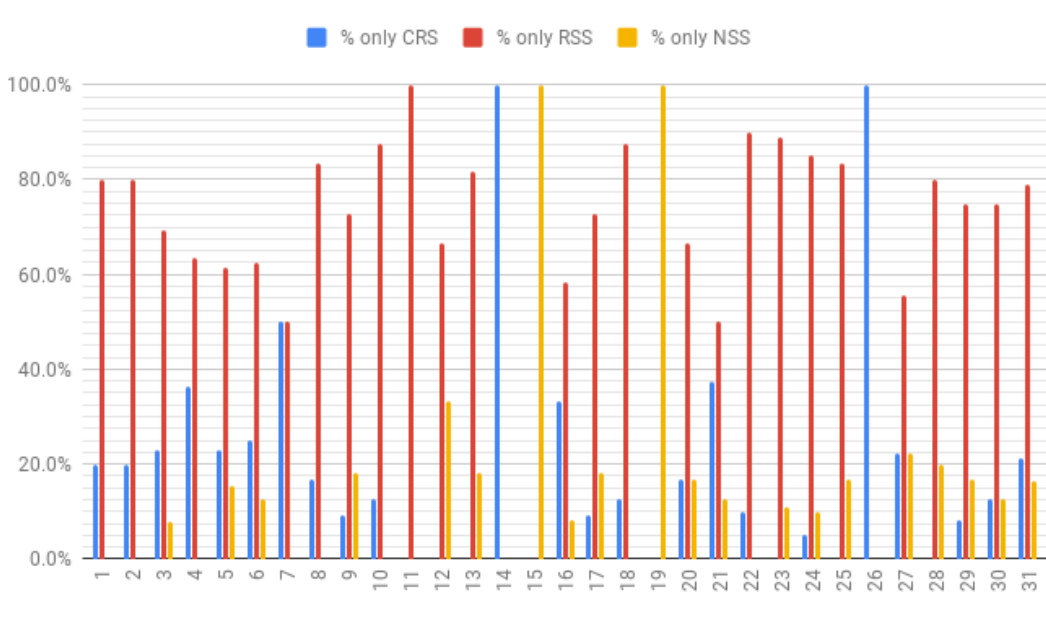
Figure 16. Percentage of the types of services on each datasheet of the paleobiology